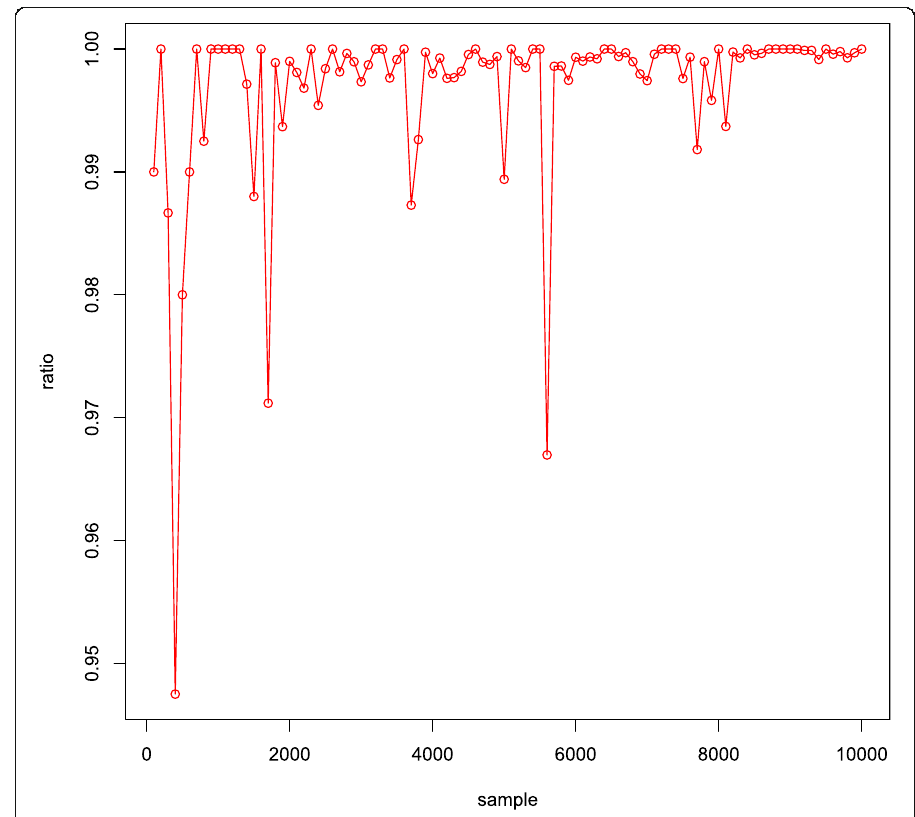
Fig. 1 The impact of sample size on the accuracy of the